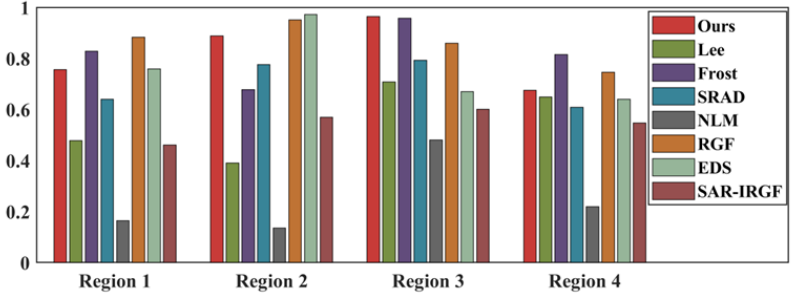
Figure 13. EPI results for the speckle suppression on synthetic image.